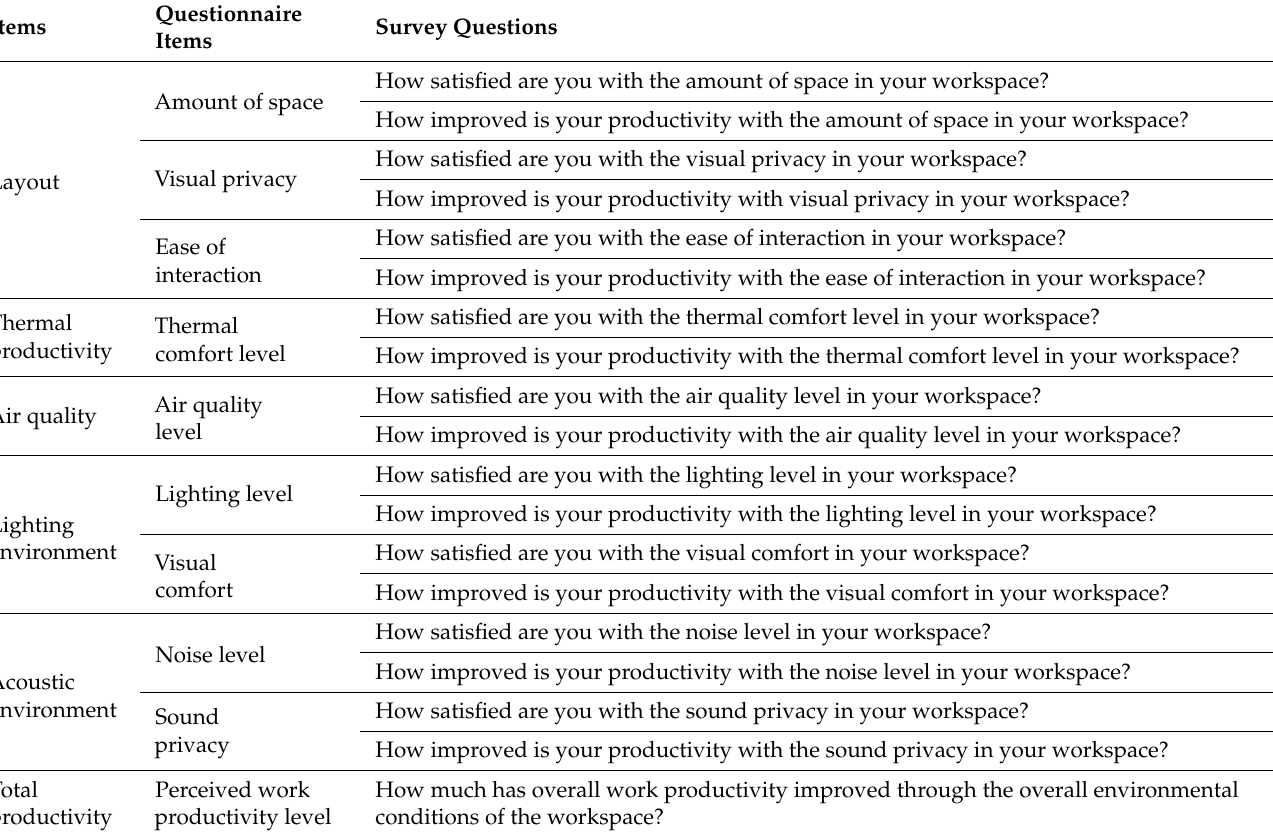
Table 3. Information of IEQ survey